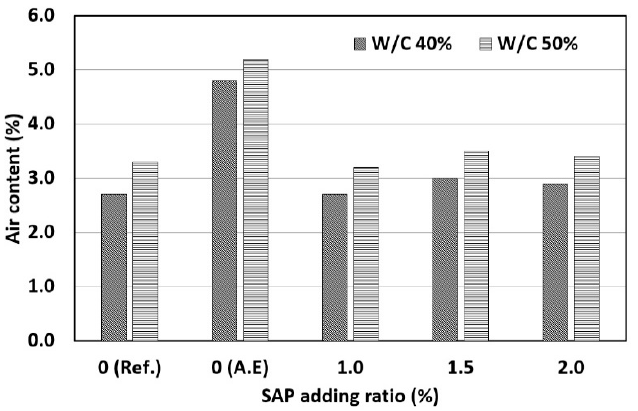
Figure 7. Results of air